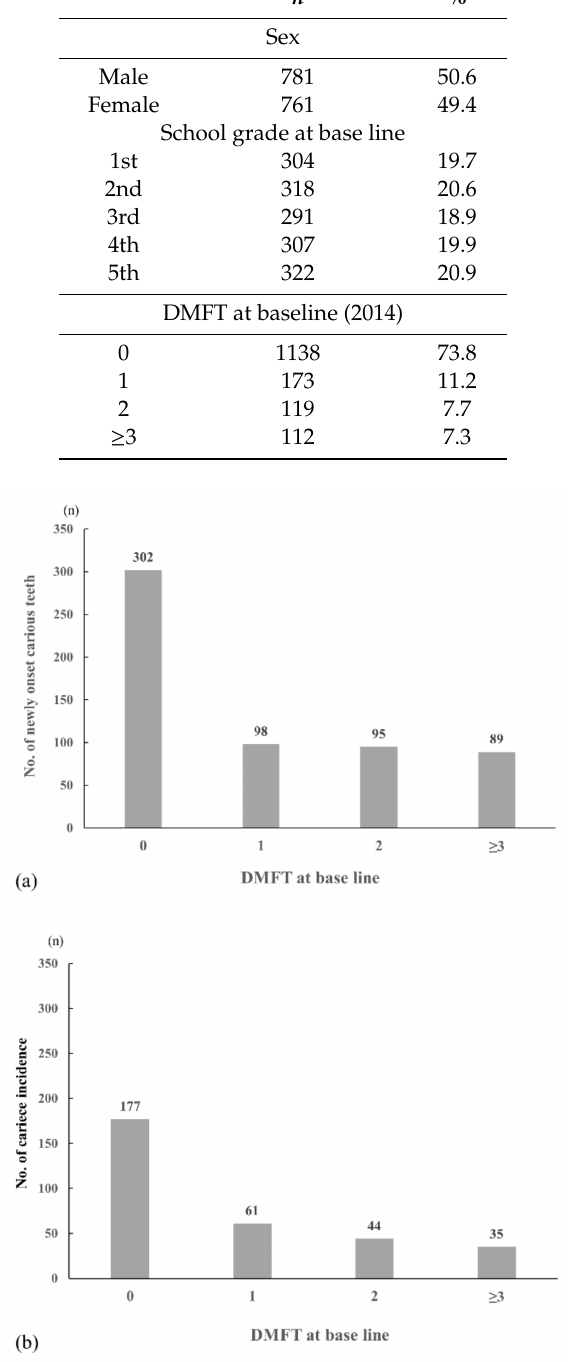
Figure 2. ( a ) Number of newly onset carious teeth at the one-year follow-up by DMFT at baseline. Most of the carious teeth occurred in students previously caries-free at baseline. ( b ) Number of participants with caries incidence during one-year follow-up by DMFT at baseline. MDFT: decayed, missing, and filled